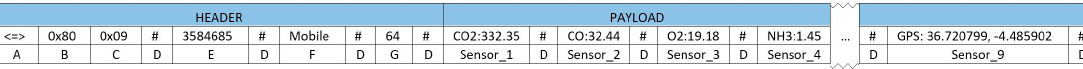
Figure 6. Part of an enhanced frame.